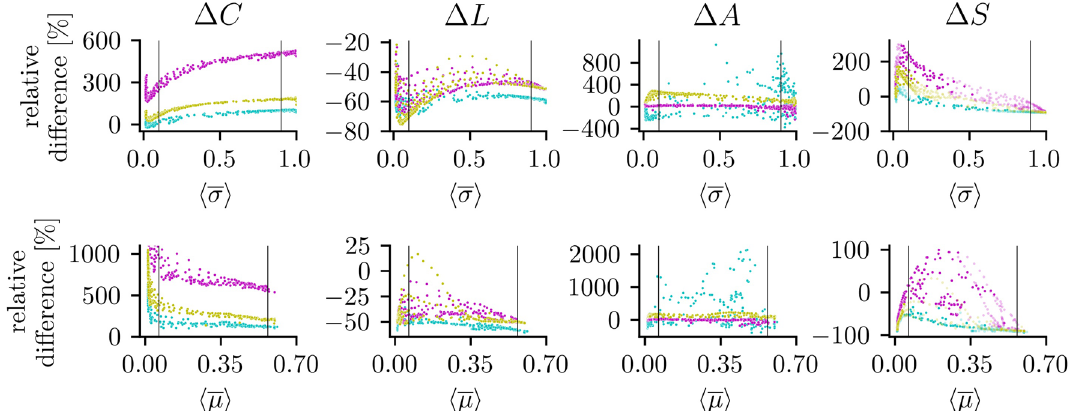
Figure 3. Relative difference (cid:31) M of global network aspects depending on average strength of interactions. M is a placeholder for measures of global network aspects: global clustering coefficient C , average shortest path length L , assortativity A , and synchronizability S . Relative differences are averages derived from 20 realizations of network dynamics, and colors indicate types of coupling topology (magenta: random, mustard: scale-free, and cyan: small-world). Average strength of interaction estimated with maximum-lag cross correlation ( (cid:31) σ (cid:30) ; top) and mutual information ( (cid:31) µ (cid:30) ; bottom; cf. Fig. 1). Vertical lines indicate borders between regimes I and II and between regimes II and III. For (cid:31) S , we additionally indicate with the transparency of dots the correlation between eigenvalue spectra of the structural and the functional networks’ Laplacian matrices: solid dots indicate a Pearson correlation coefficient of larger than 0.98 and faded dots illustrate a lower correlation